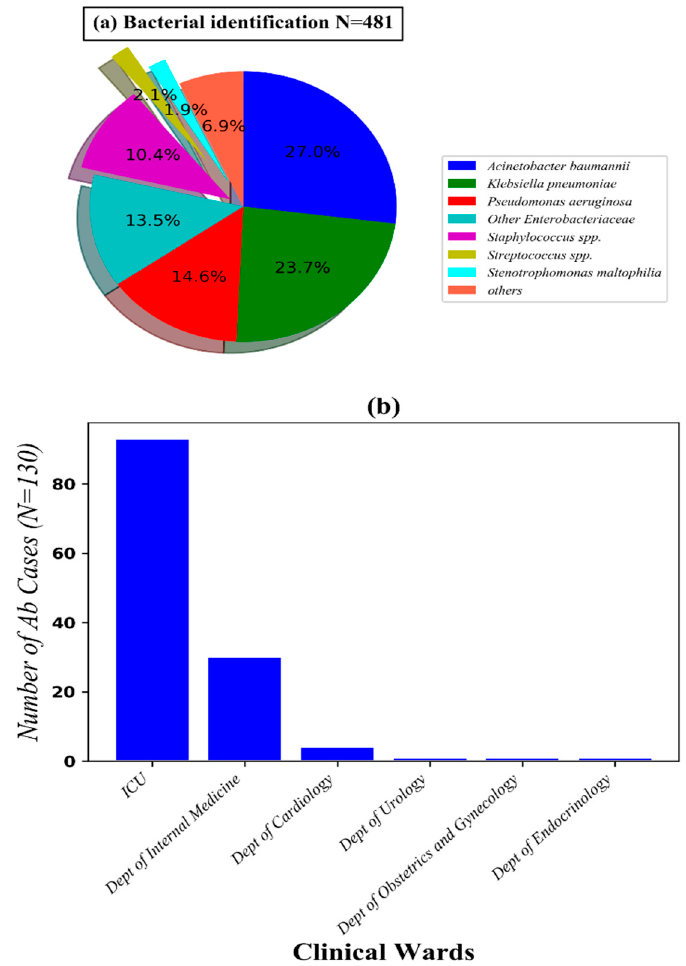
Figure 1. The proportion of pathogens isolated from patients and their distribution according to clinical wards.